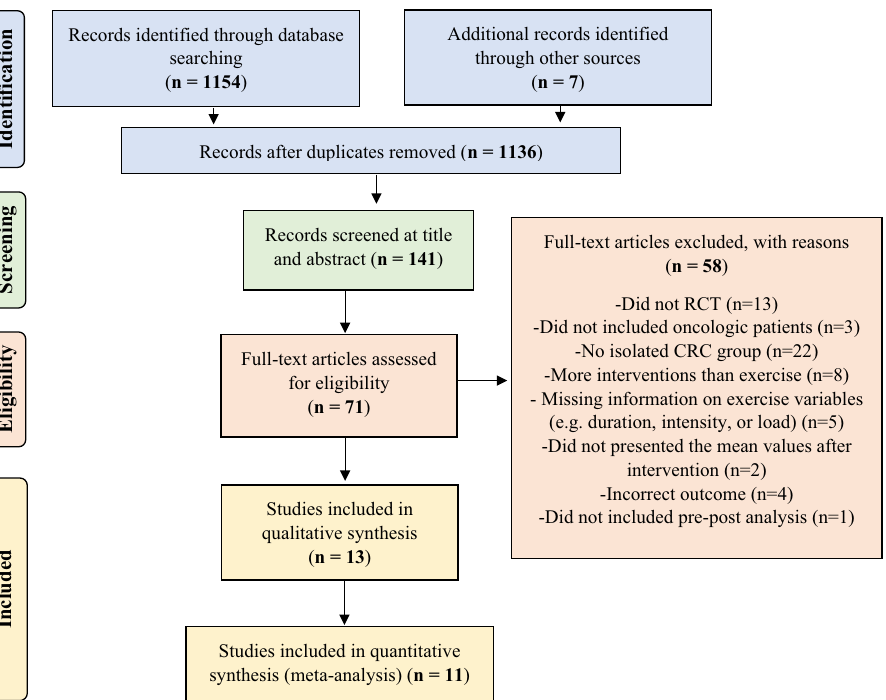
Figure 1. Flow diagram of the preferred reporting items for systematic reviews and meta-analyses